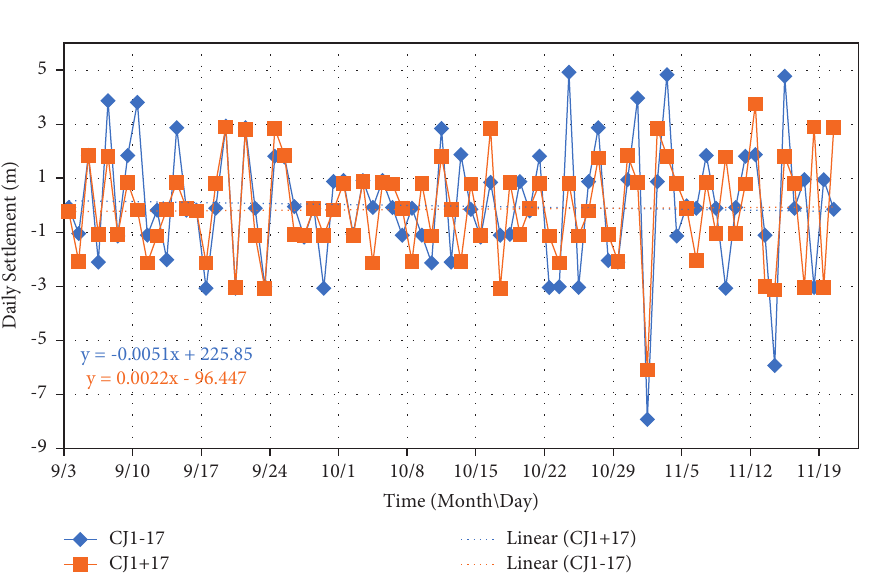
Figure 4: Daily settlement of CJ1-17 and CJ1 +17.